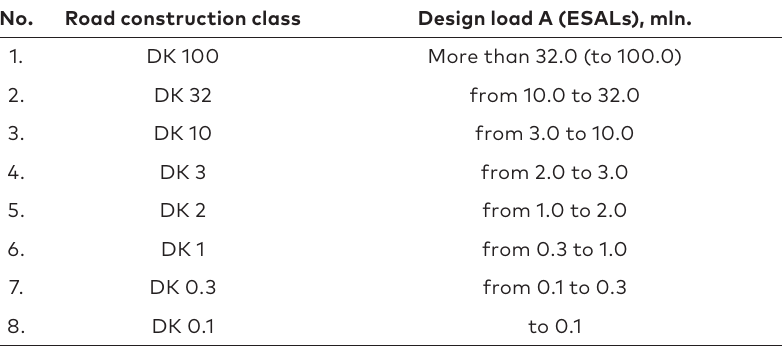
Table 2. Road construction class and range of ESALs